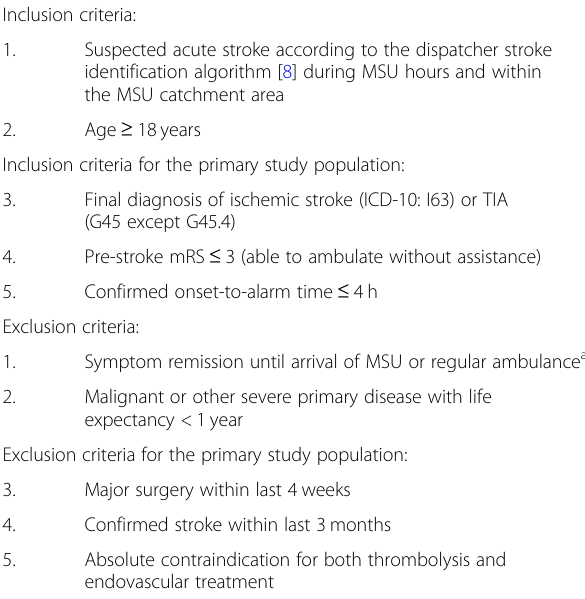
Table 1 Inclusion and exclusion criteria for the study population